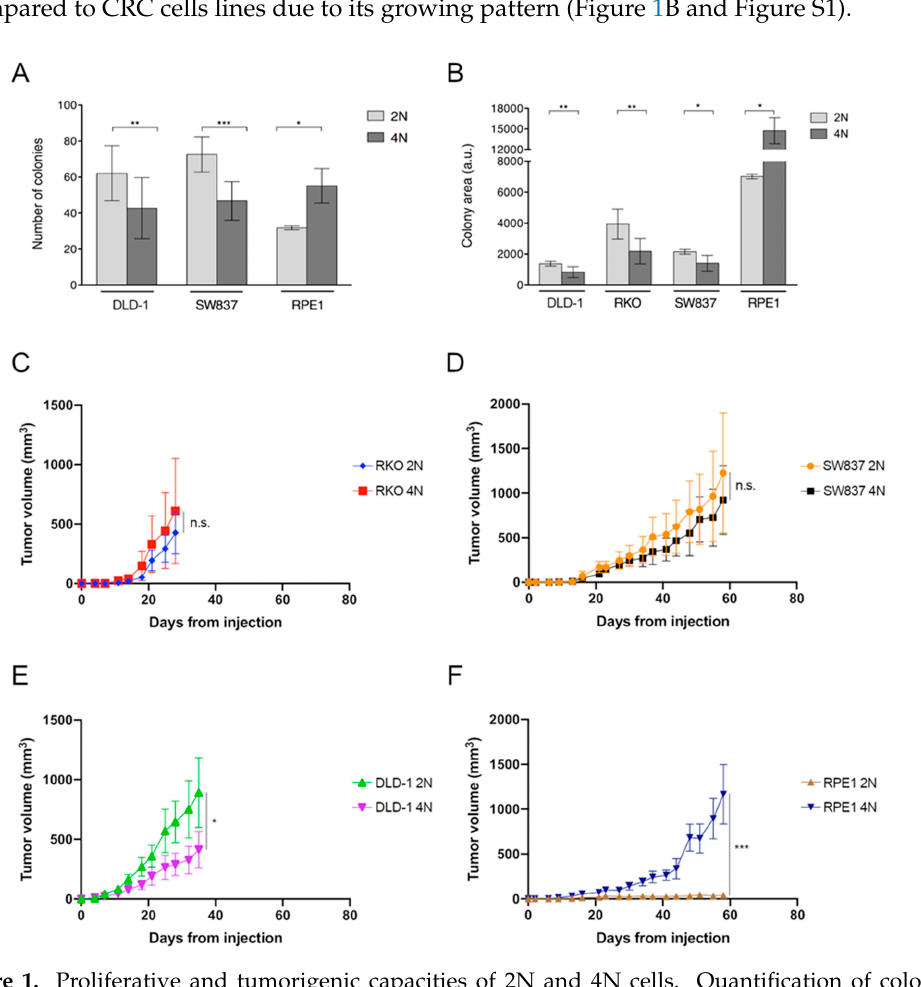
Figure 1. Proliferative and tumorigenic capacities of 2N and 4N cells. Quantification of colony formation assay by ( A ) number of colonies and ( B ) area of occupancy in one 2N and two 4N clones derived from the different cell lines. Please note that analysis of the number of colonies for the RKO cell line was not possible due to its dispersed phenotype in the colony-forming assay. Mean of at least two replicates from three independent experiments with SD is shown. Measurements of tumor volumes after injecting ( C – E ) CRC and ( F ) non-transformed RPE1 2N and 4N cells subcutaneously in athymic nude mice. A.u., arbitrary units. *, p < 0.05; **, p < 0.01; ***, p < 0.001. To analyze their capacity to induce tumorigenesis, 1 × 10 6 2N and 4N cells from DLD-1, RKO, SW837 and RPE1 cell lines were injected subcutaneously in athymic nude mice. For RKO and SW837, results indicated that 4N cells show the same tumorigenic capacity as 2N cells with no statistical di ff erences in tumor growth. As for DLD-1, 2N and 4N cells displayed the same capacity to